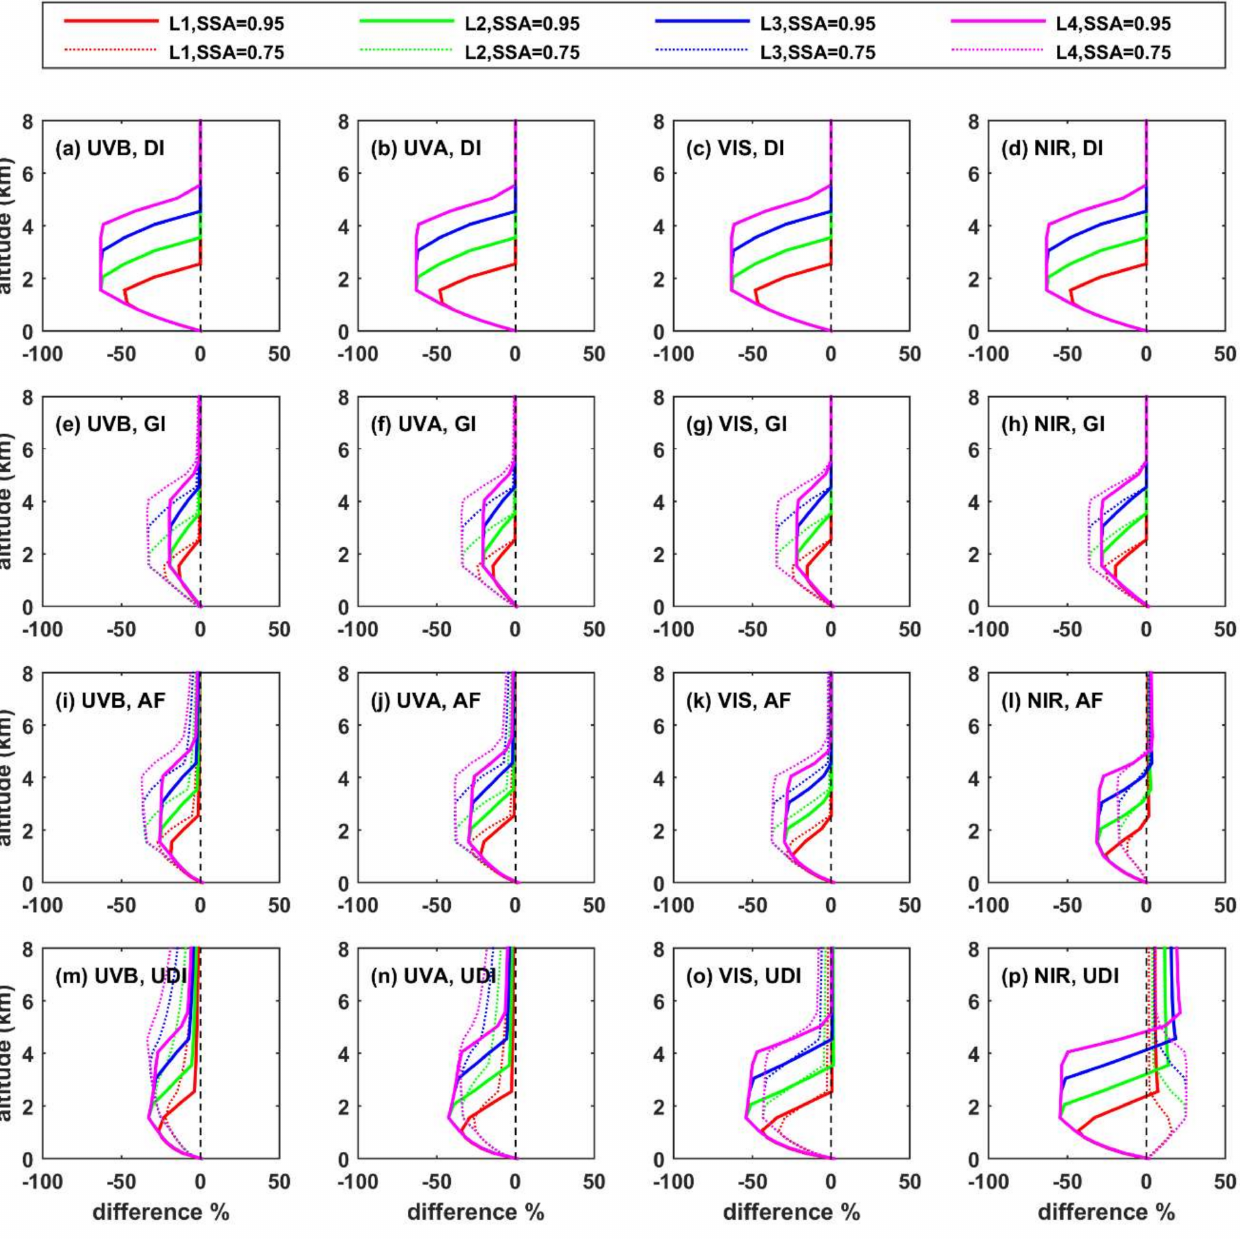
Figure A2. Same as Figure 3, but for AOD = 0.5 instead of AOD =